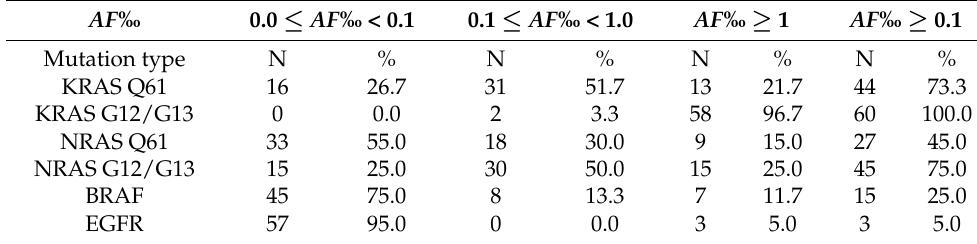
Table 1. Descriptive statistics of mutation levels.